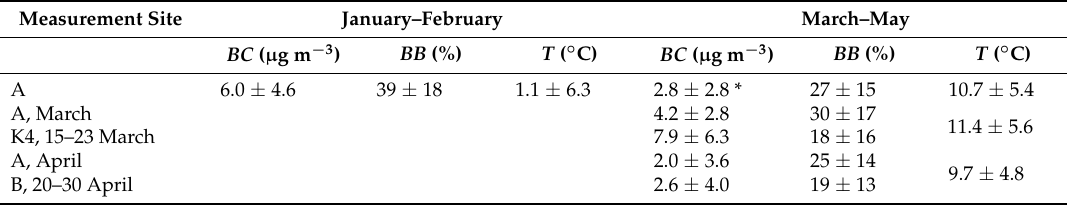
Table 1. Summary (mean ± standard deviation) of BC (Black Carbon) concentration, biomass burning fraction (BB) and air temperature ( T ) for the first and the second part of measurement campaign at the background site A and for intersections K4 and site B.